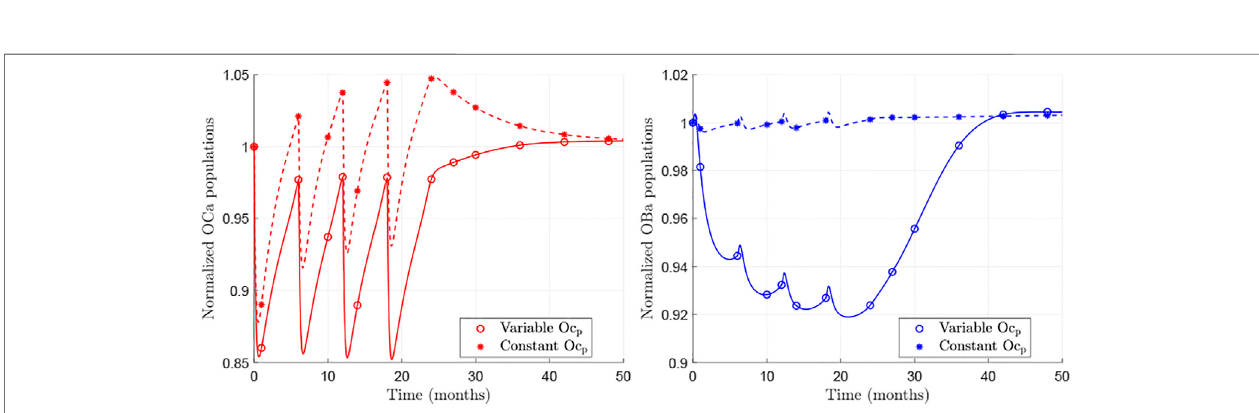
FIGURE 2 | Comparison between clinical results (from Bone et al. (Bone et al., 2011)) and in-silico results of changes in BMD with respect to baseline for two different bone sites: lumbar spine (left) and hip (right).